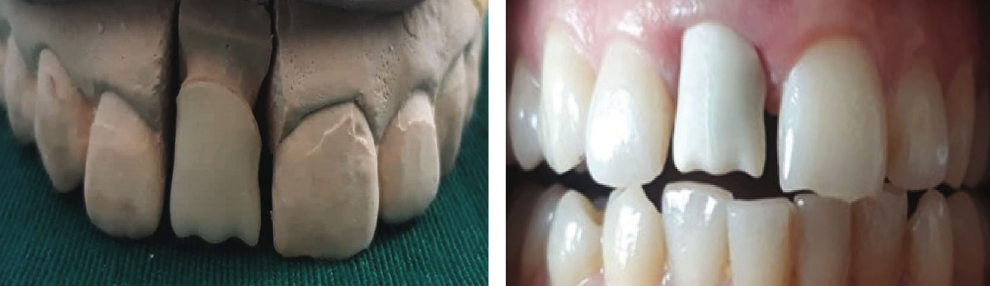
Figure 6: The checking of zirconia framework.